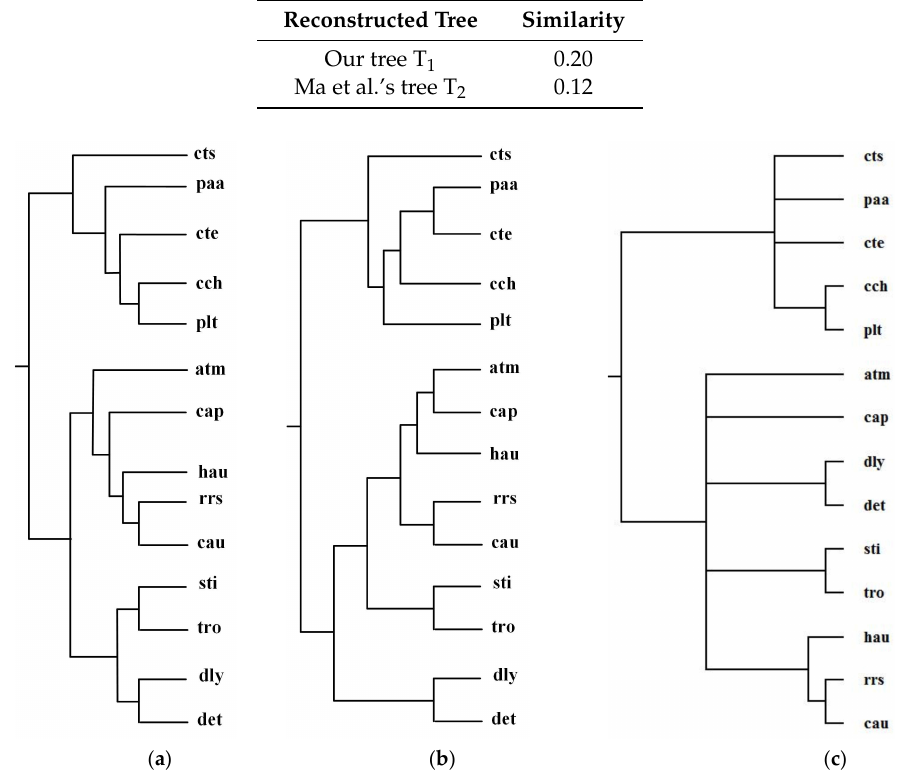
Table 2. Similarity of reconstructed tree to the NCBI taxonomy T for the organisms in Figure 7.